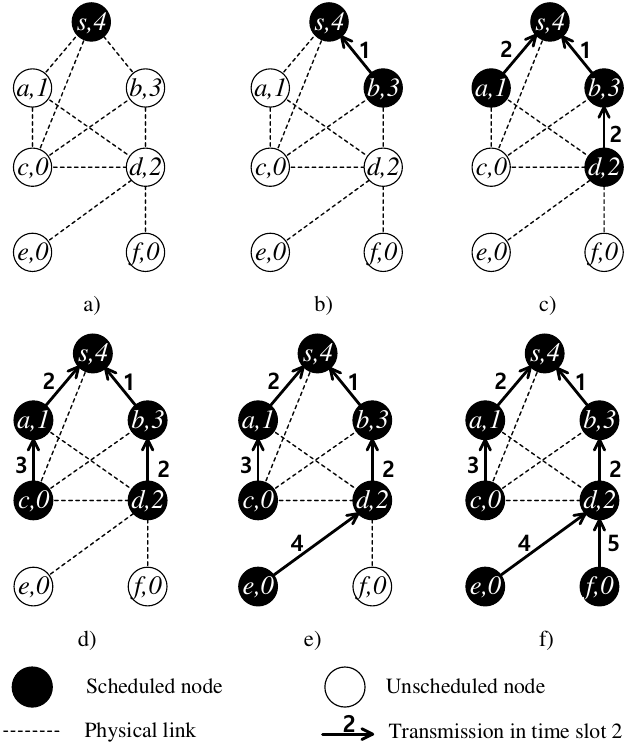
Figure 6. A step-by-step illustration of the proposed scheduling